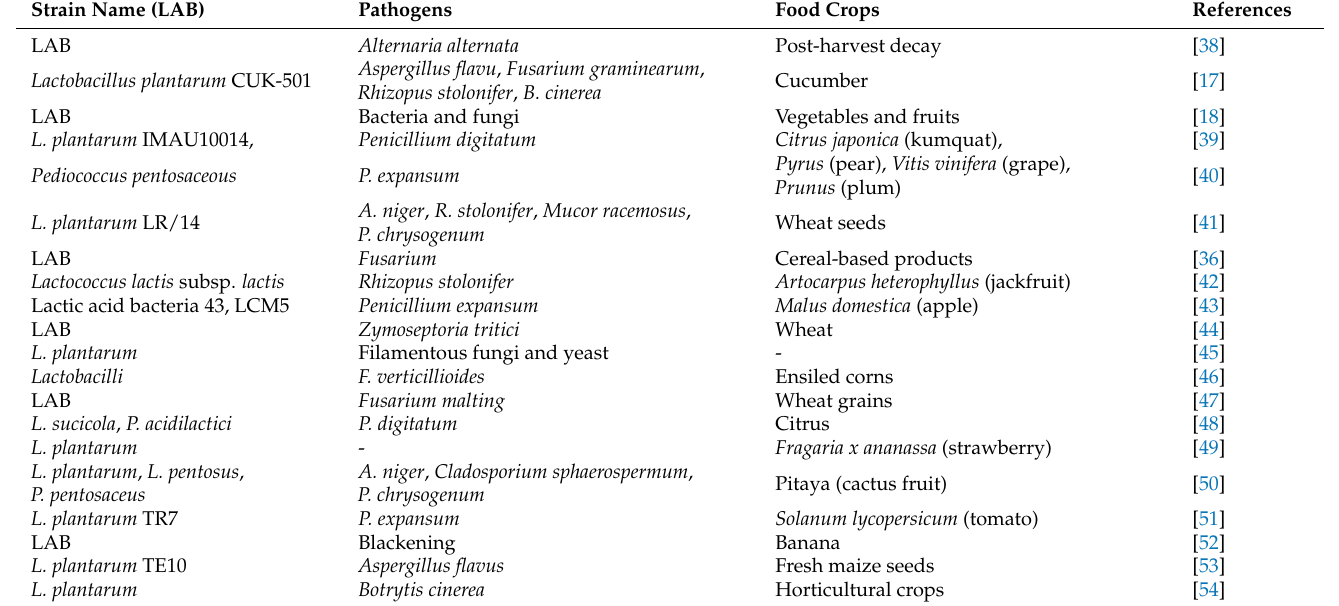
Table 1. Biocontrol properties of LAB on agricultural and horticultural